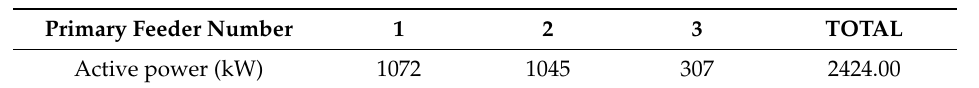
Table 4. SCHPS power consumption *.